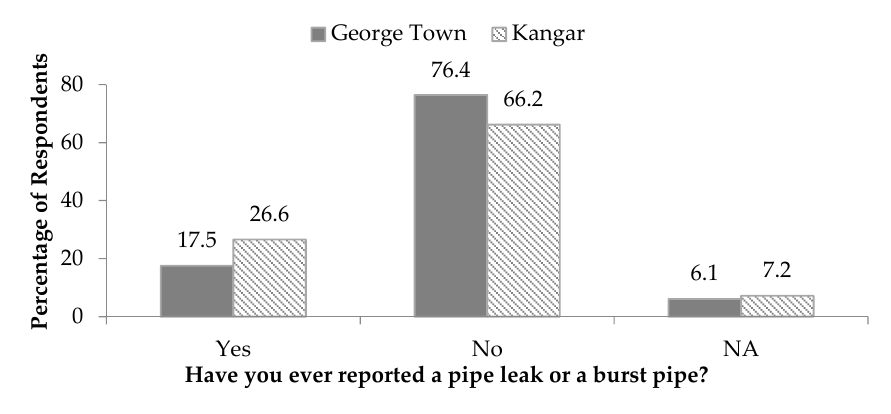
Figure 8. Action towards pipe leaking or pipe burst issue.